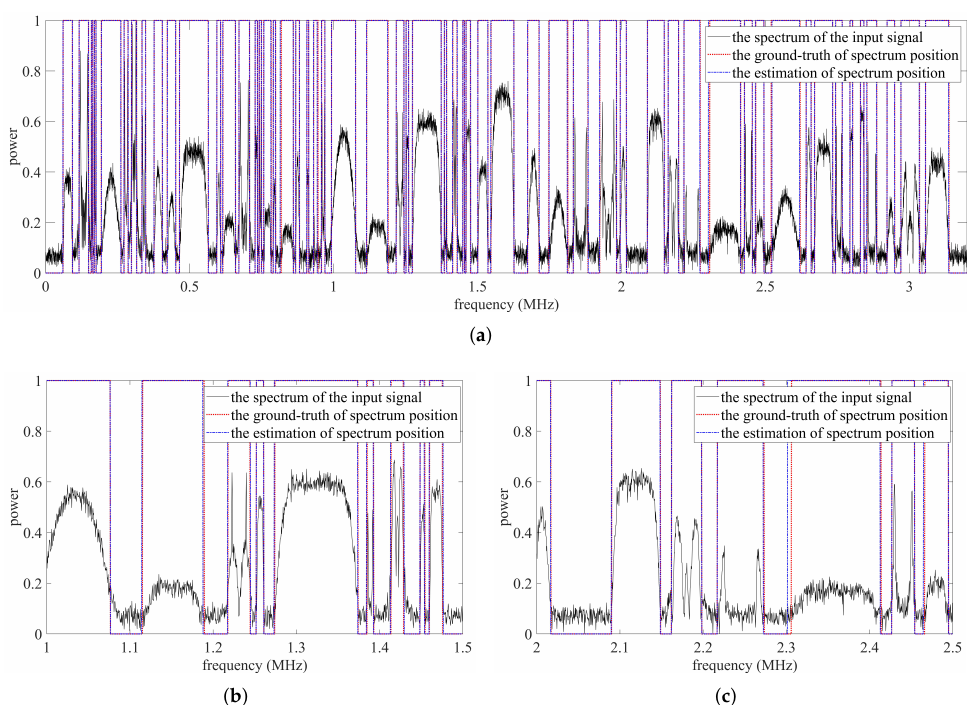
Figure 14. Predicted results for the second example. ( a ) The whole band of the second prediction example. ( b ) The sub-band_1 of the second prediction example. ( c ) The sub-band_2 of the second prediction